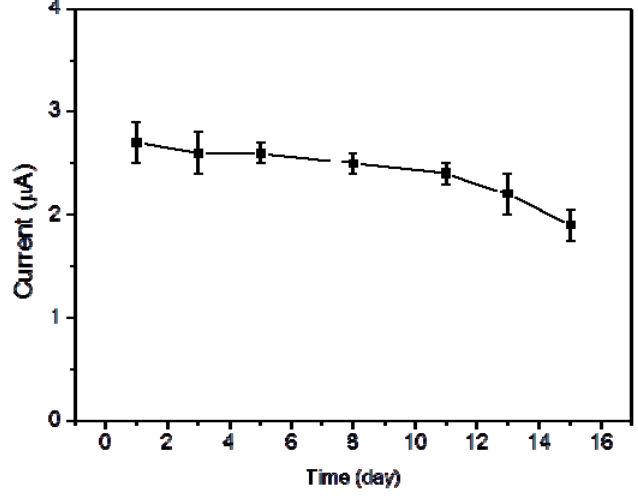
Figure 6. Long-term stability of the biosensor based on GO–peptide–AgNPs